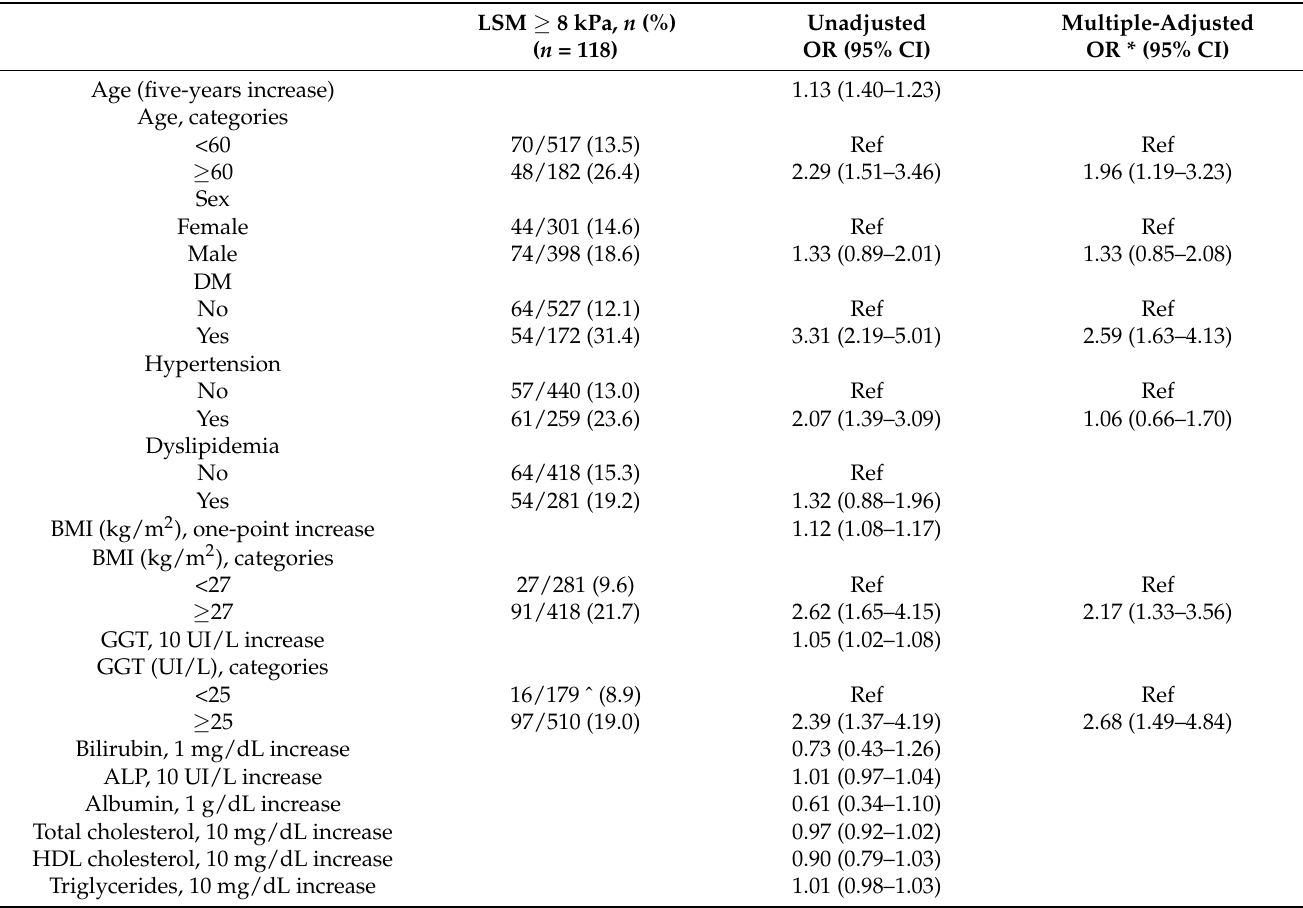
Table 3. Odds ratios (OR), and corresponding 95% confidence intervals (CI), of increased liver stiffness (LSM ≥ 8 kPa) by transient elastography according to selected demographic, laboratory, metabolic and clinical factors in 699 NAFLD patients with FIB-4 < 1.3.